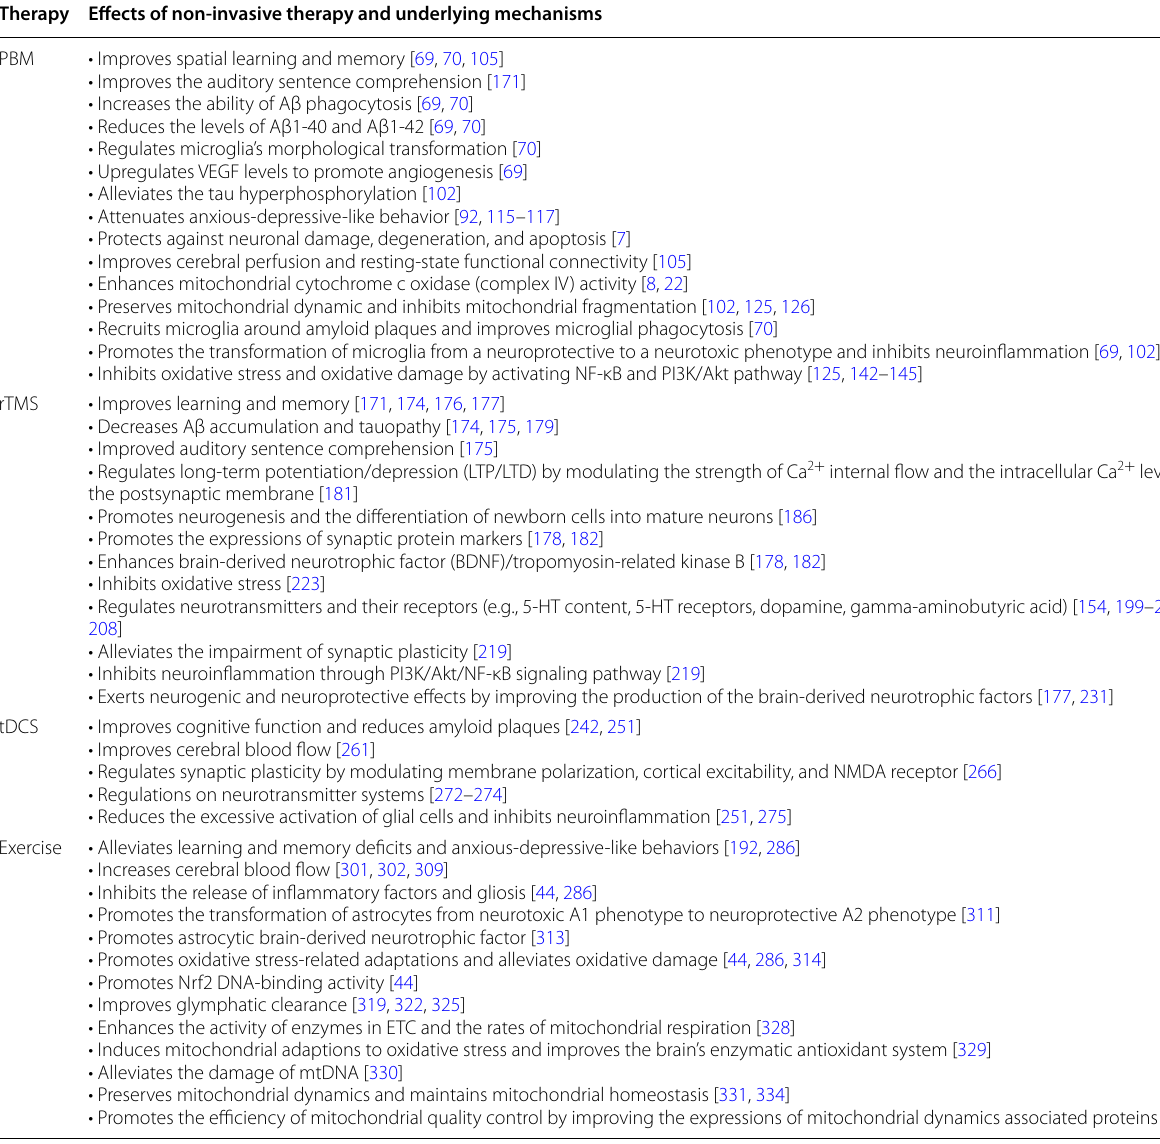
VEGF Vascular endothelial growth factor, Nrf2 Nuclear erythroid 2-related factor 2